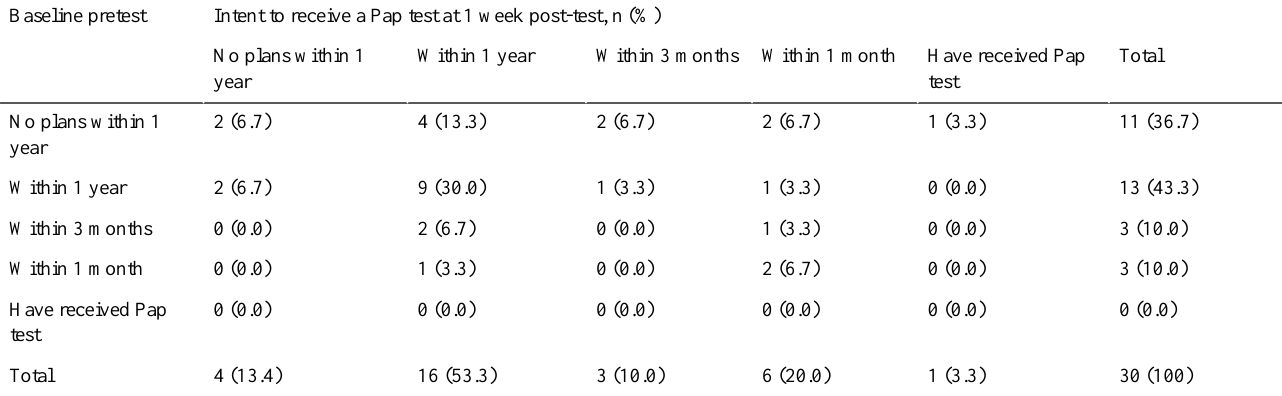
Table 3. Intention to receive the Pap test before and after the mScreening intervention (N=30).